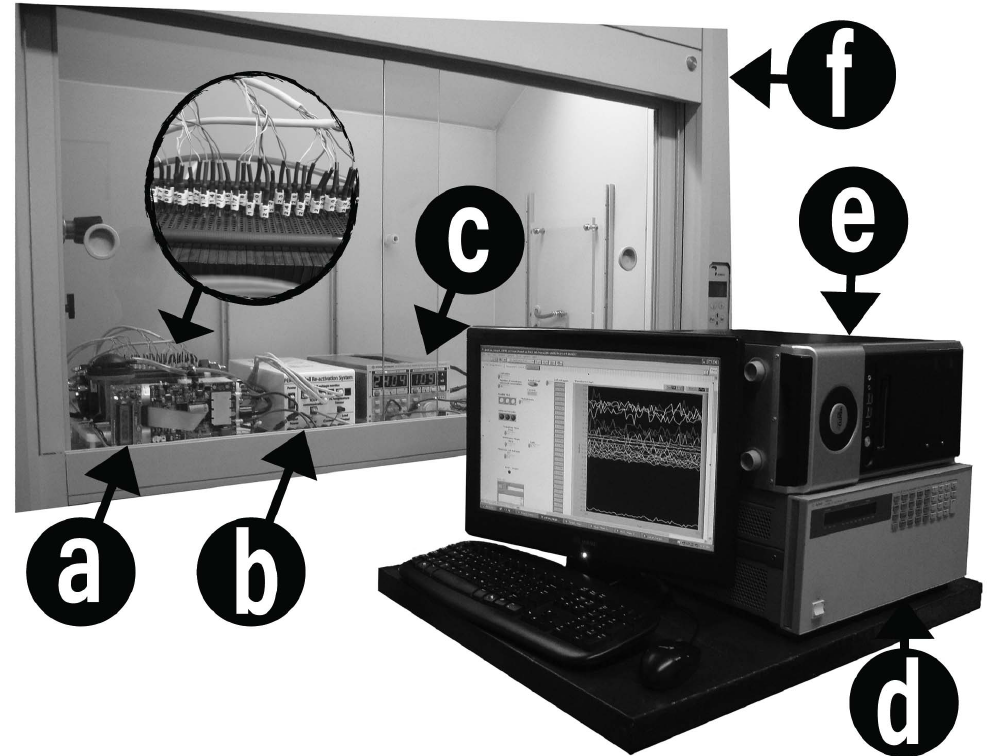
Experimental configuration using to FC reactivation: ( a ) PC3F40